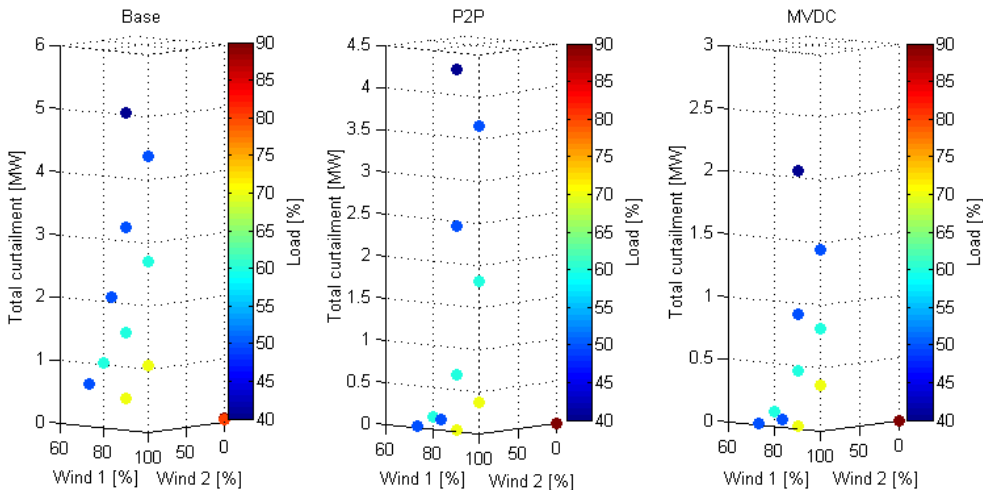
Figure 9. The comparison of total DG curtailment at different system configurations.